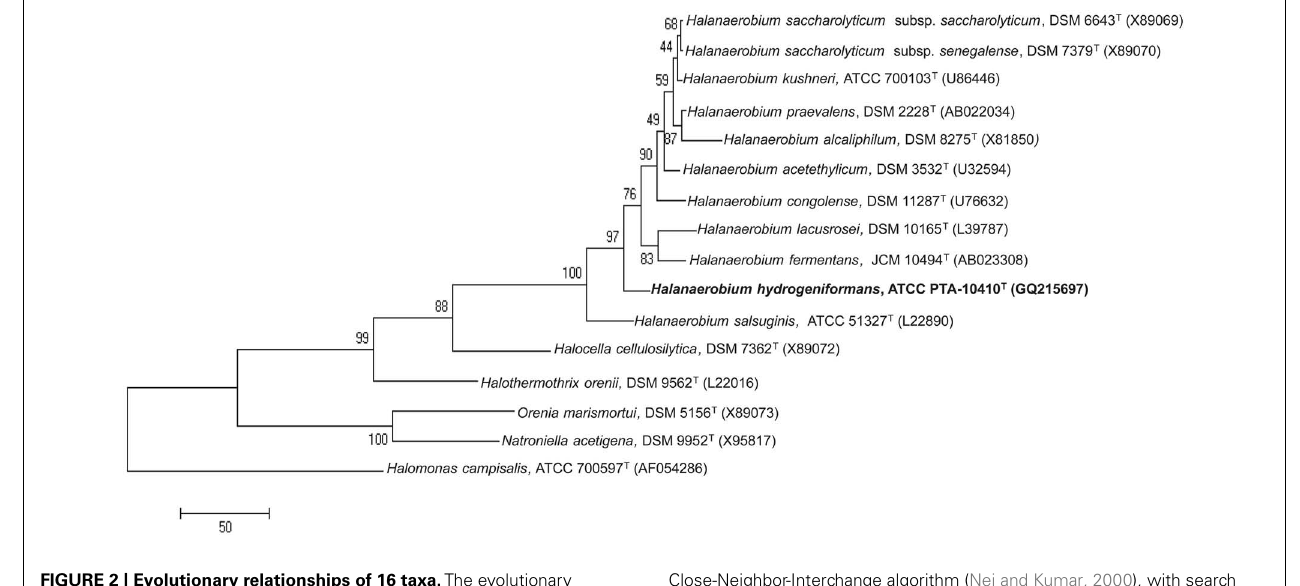
FIGURE 2 | Evolutionary relationships of 16 taxa. The evolutionary history was inferred using the maximum parsimony method (Eck and Dayhoff, 1966).The bootstrap consensus tree inferred from 1000 replicates is taken to represent the evolutionary history of the taxa analyzed (Felsenstein, 1985). Branches corresponding to partitions reproduced in less than 50% bootstrap replicates are collapsed.The percentage of replicate trees in which the associated taxa clustered together in the bootstrap test (1000 replicates) are shown next to the branches (Felsenstein, 1985).The MP tree was obtained using the